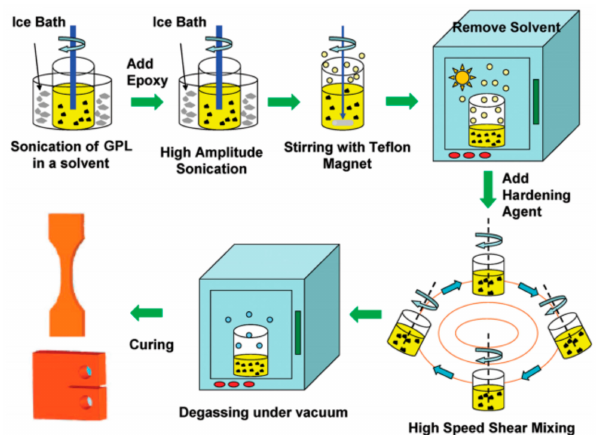
Figure 6. Solution mixing for manufacture of graphene-reinforced polymer composites (GRPCs). Reproduced with permission from the authors of [5]. Copyright 2009, American Chemical Society.